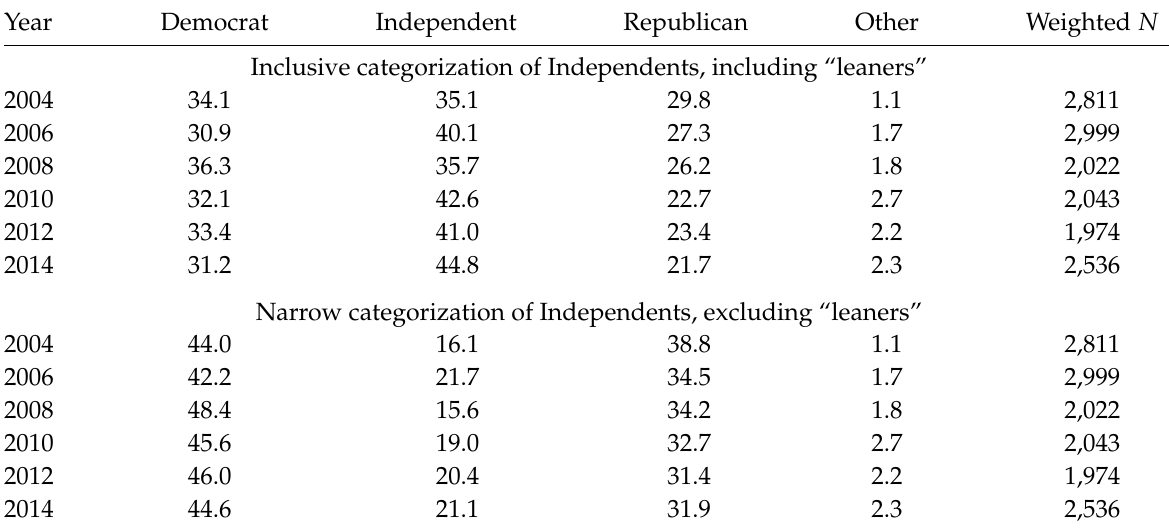
Table 1: Percentage Self-identified Political Party by Year, 2004-2014 Cross-Sectional Samples of the GSS Year Democrat Independent Republican Other Weighted N Inclusive categorization of Independents, including